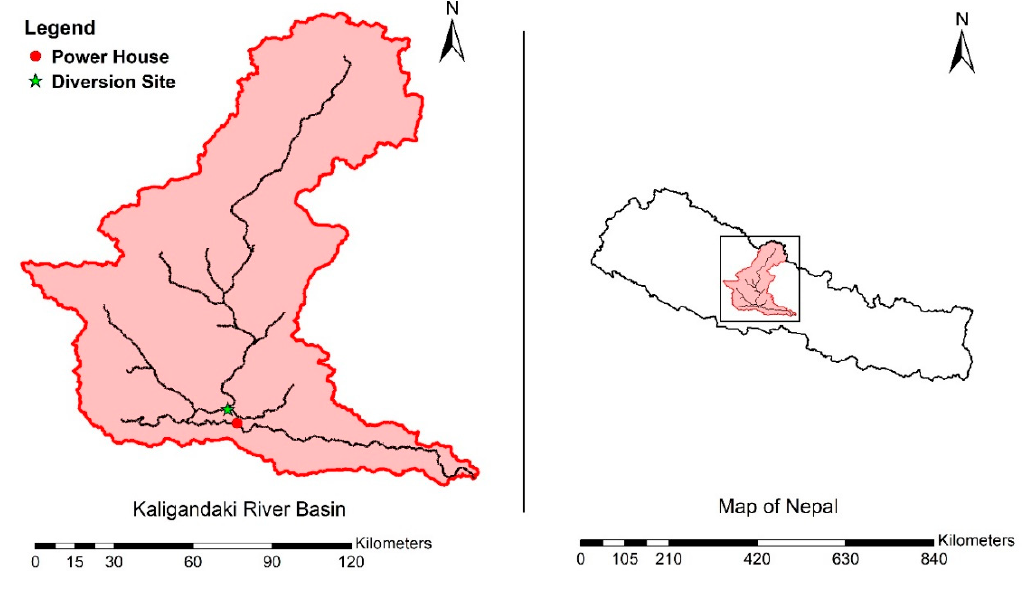
Figure 1. The study area, Kaligandaki River basin.